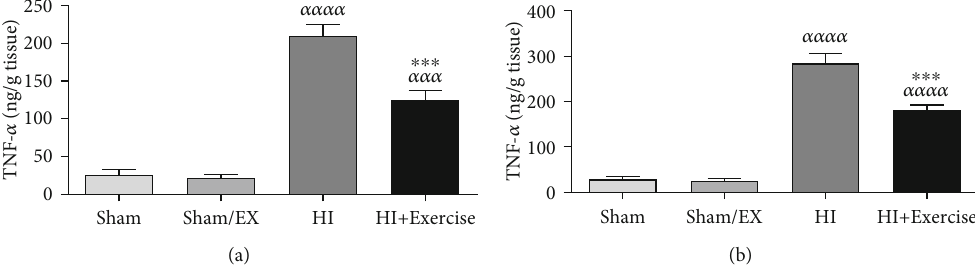
Figure 2: E ff ect of exercise during pregnancy on TNF- α levels after HI in female (a) and male (b) pups. HI: hypoxia-ischemia. ααα P < 0 : 001 , αααα P < 0 : 0001 as compared with the sham and sham/EX. ∗∗∗ P < 0 : 001 as compared with the HI. Data are expressed as the mean ± S : E : M : ( n = 10